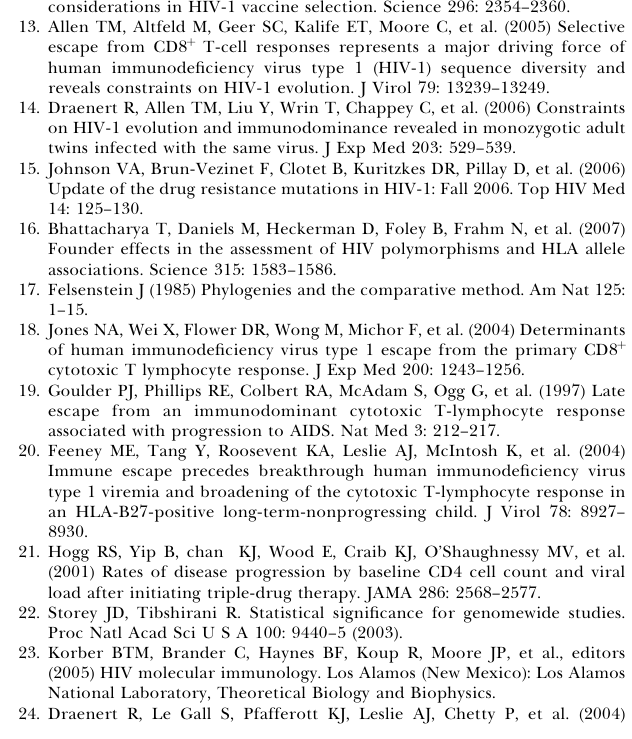
‘‘ Escape ’’ amino acids indicate amino acids that are enriched in the presence of a specific HLA allele, thus presumably reflecting the escape variant specific for that HLA allele. ‘‘ Reversion ’’ amino acids indicate amino acids that are enriched in the absence of a specific allele (or likewise, depleted in the presence of a specific HLA allele). ‘‘ Reversion ’’ amino acids presumably reflect the immunologically susceptible (‘wild-type ’’ ) form specific for that HLA allele, and also represent the amino acid to which the sequence may revert upon transmission to an individual lacking that HLA allele. Table S2. Full List of HLA Linkage Disequilibrium Pairs Observed in Our Dataset ( p , 0.05, q ,